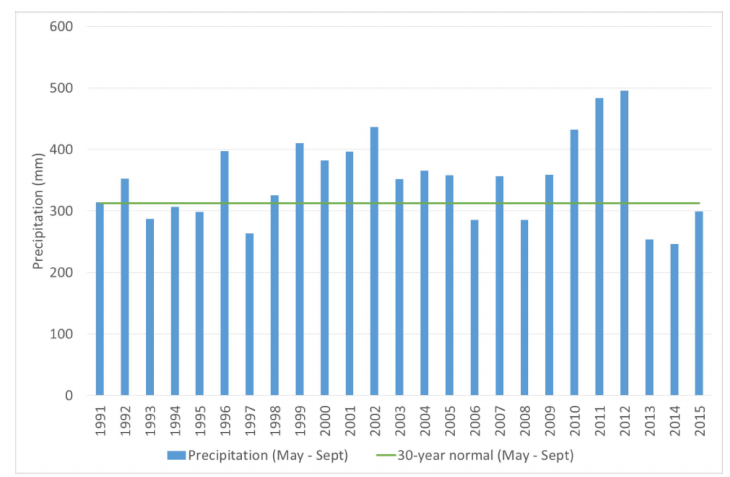
Figure 5. Precipitation during the growing season (1 May until 31 October) for the location Ilseng (near Jønsberg) in Eastern Norway, compared to the 30-year normal (green line) for precipitation